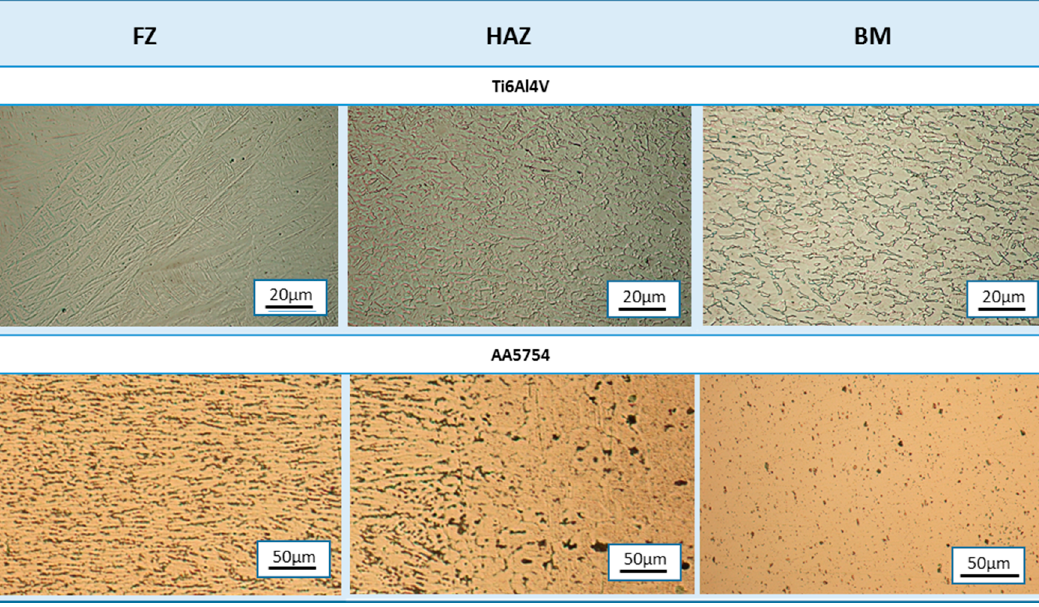
Figure 7. Microstructure of the various zones in Ti6Al4V and AA5754.